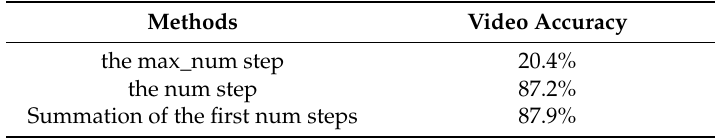
Table 3. Comparison of different LSTM inferences in the RGB stream of 8f temporal scale on UCF101